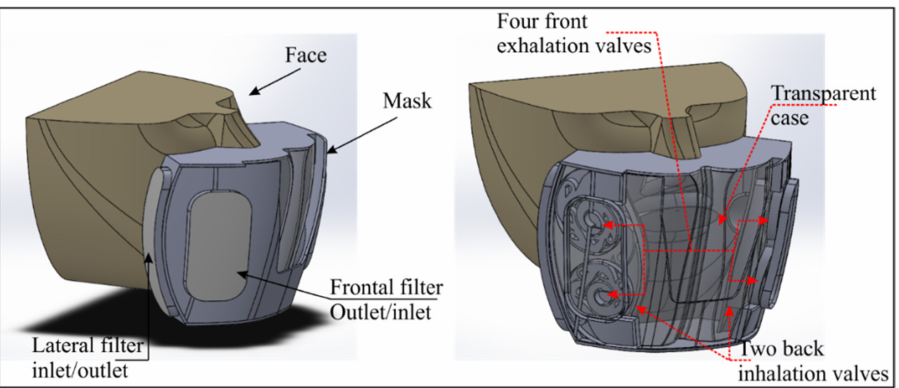
Figure 1. Geometric model of the mask and its main components.